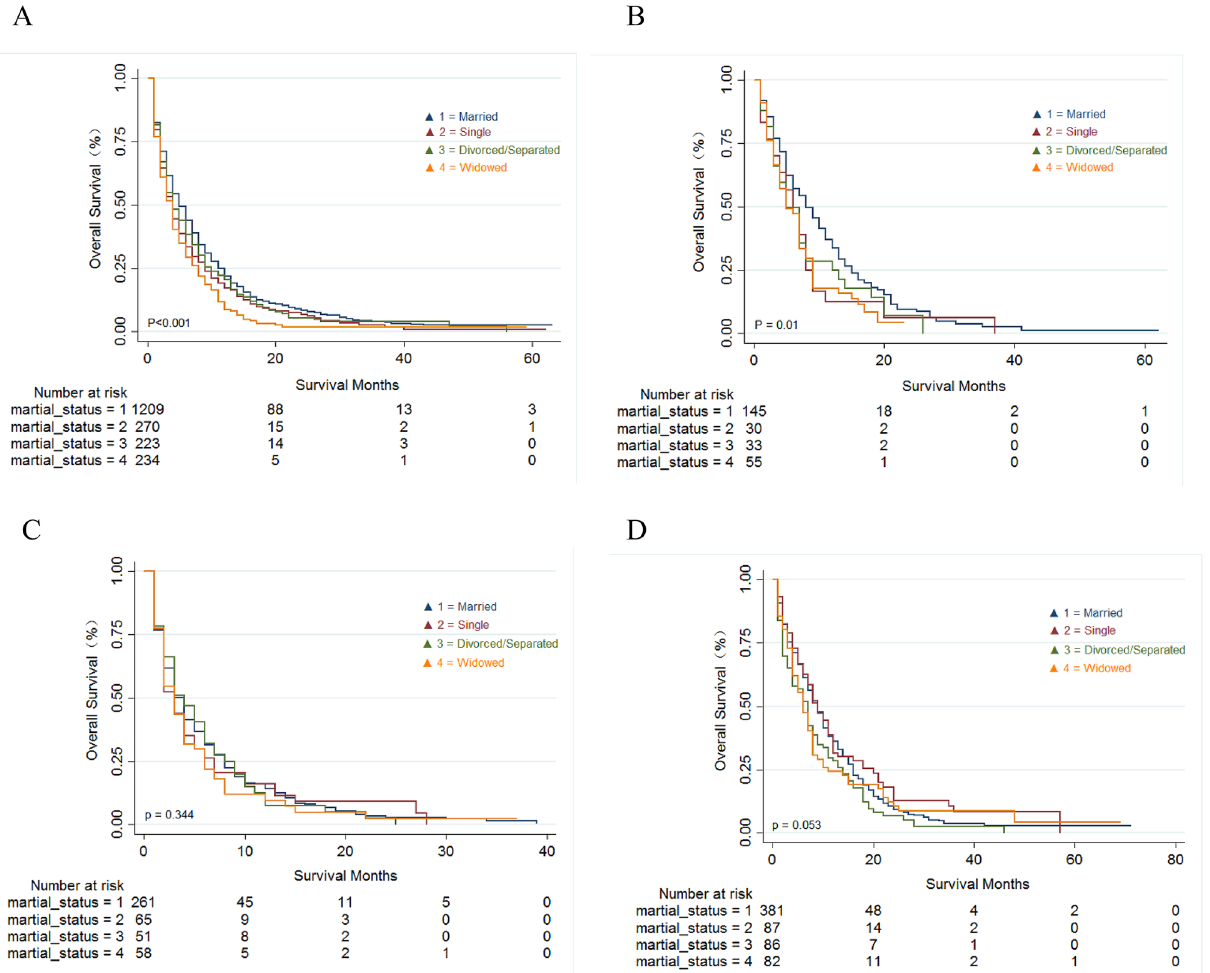
Figure 4. Kaplan–Meier survival analysis of overall survival (OS) in PDAC patients with different marital status with only liver metastasis ( A ), only lung metastasis ( B ), metastases at multiple sites ( C ) and other lymph node metastases ( D